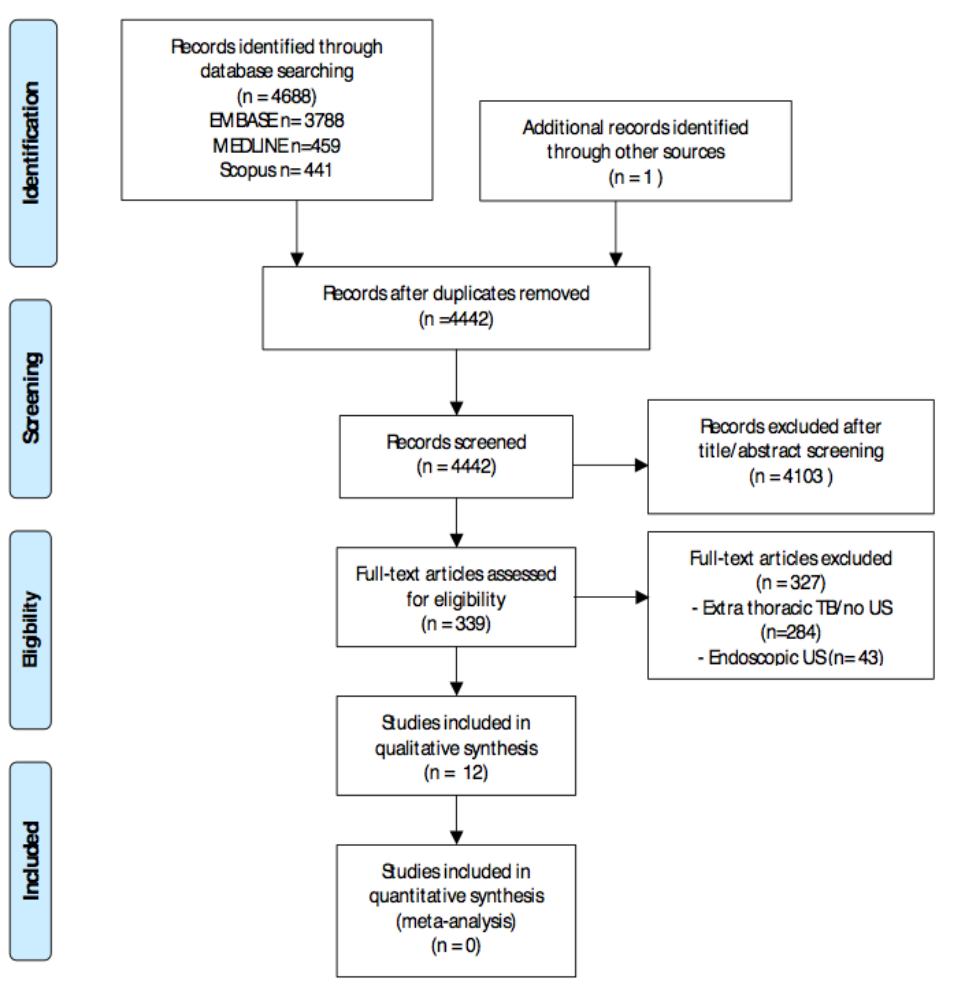
Figure 1. PRISMA (Preferred Reporting Items for Systematic Reviews and Meta-Analyses) flow diagram. Abbreviations: Tuberculosis (TB) and ultrasound (US).